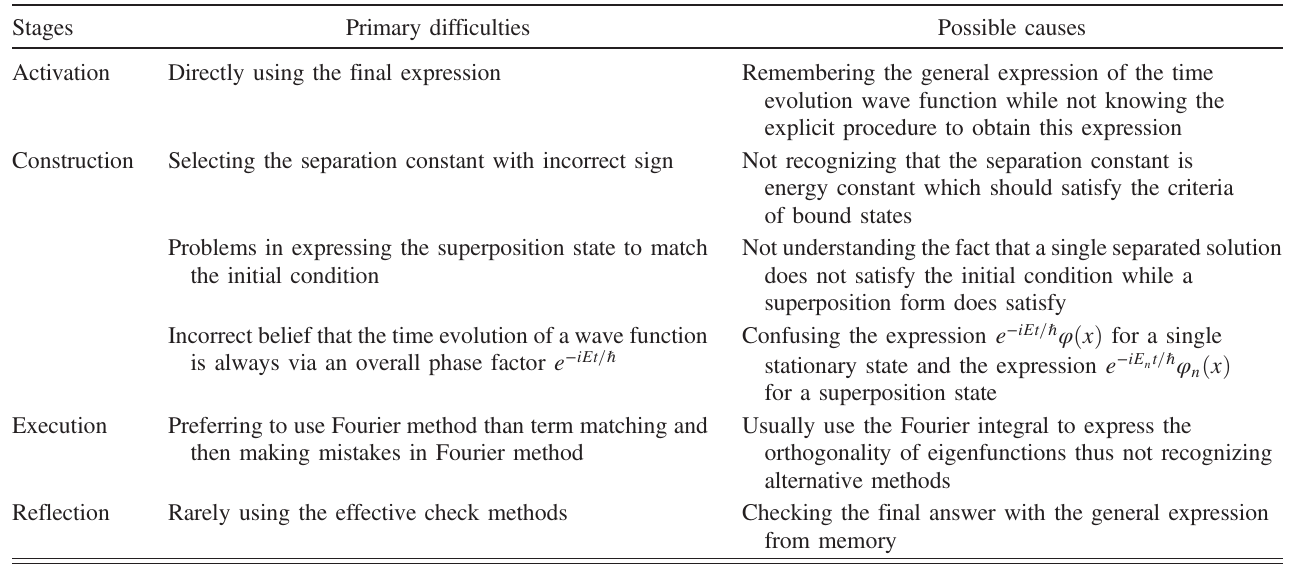
TABLE X. Primary difficulties of students on solving the time evolution problem, and the possible causes to which they relate.